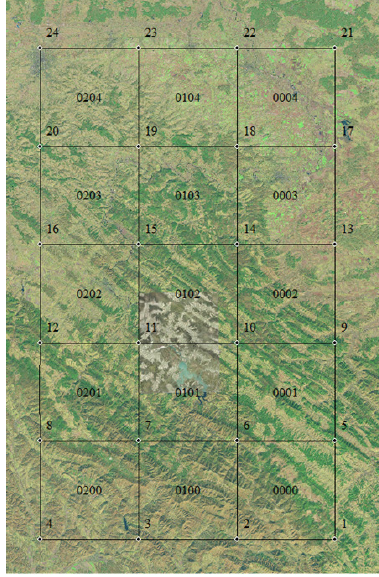
Fig. 10. Division of the terrain into “tiles” in Terragen program against the source data